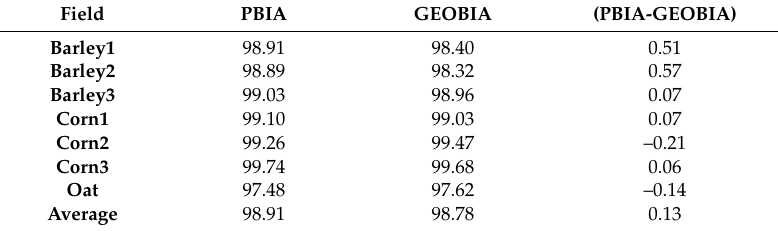
Table 12. Area goodness of fit (%) computed by comparing the manually- and machine-delineated field areas for the pixel-based image analysis and geographic object-based image analysis classifications.